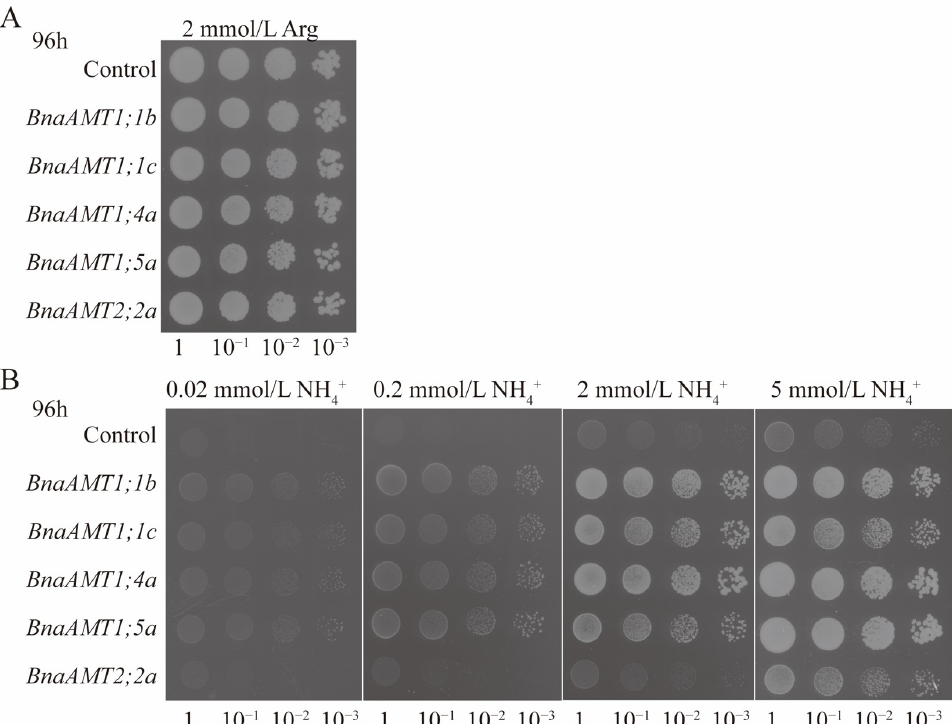
Figure 8. Functional complementation of the yeast mutant 31019b defective in NH 4+ uptake by heterologous expression of BnaAMTs ( BnaAMT1;1b , BnaAMT1;1c , BnaAMT1;4a , BnaAMT1;5a , BnaAMT2;2a ). ( A ) The 31019b cells carrying the empty vector pYES2 (control), BnaAMT1;1b , BnaAMT1;1c , BnaAMT1;4a , BnaAMT1;5a , and BnaAMT2;2a were allowed yeast growth on 2 mM L-arginine as a sole N source. ( B ) The 31019b cells carrying the empty vector pYES2 (control), BnaAMT1;1b , BnaAMT1;1c , BnaAMT1;4a , BnaAMT1;5a , and BnaAMT2;2a were allowed yeast growth on 0.02, 0.2, 2, and 5 mM NH 4 Cl as a sole N source.